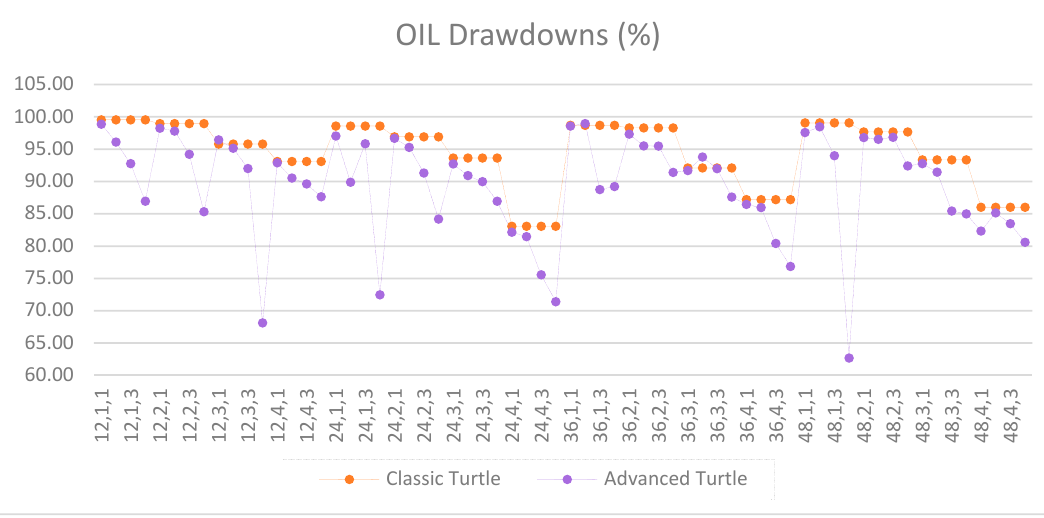
Figure A14. Drawdowns of OIL as percentage of equity between the classic and the advanced Turtle systems for every combination of N, X, Y for the fast parameters (20, 40).